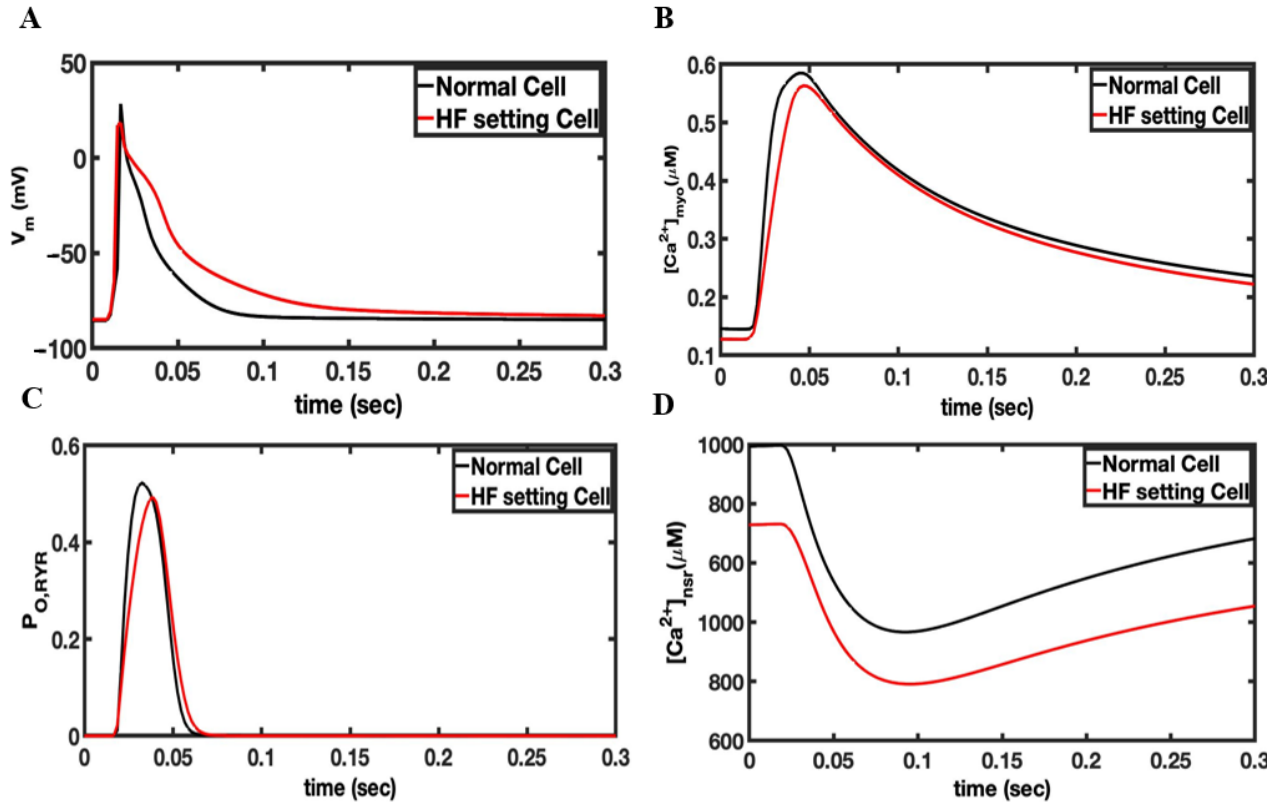
Figure 3. Comparison of simulated heart failure vs. control for the rat ventricular myocyte model. The model was paced in a single myocyte for 20 s so that steady-state pacing was obtained. ( A ) Changes in the membrane potential during an action potential. ( B ) The myoplasmic Ca 2+ concentration during an AP. ( C ) The RyR2 open probability. ( D ) The network SR Ca 2+ concentration.